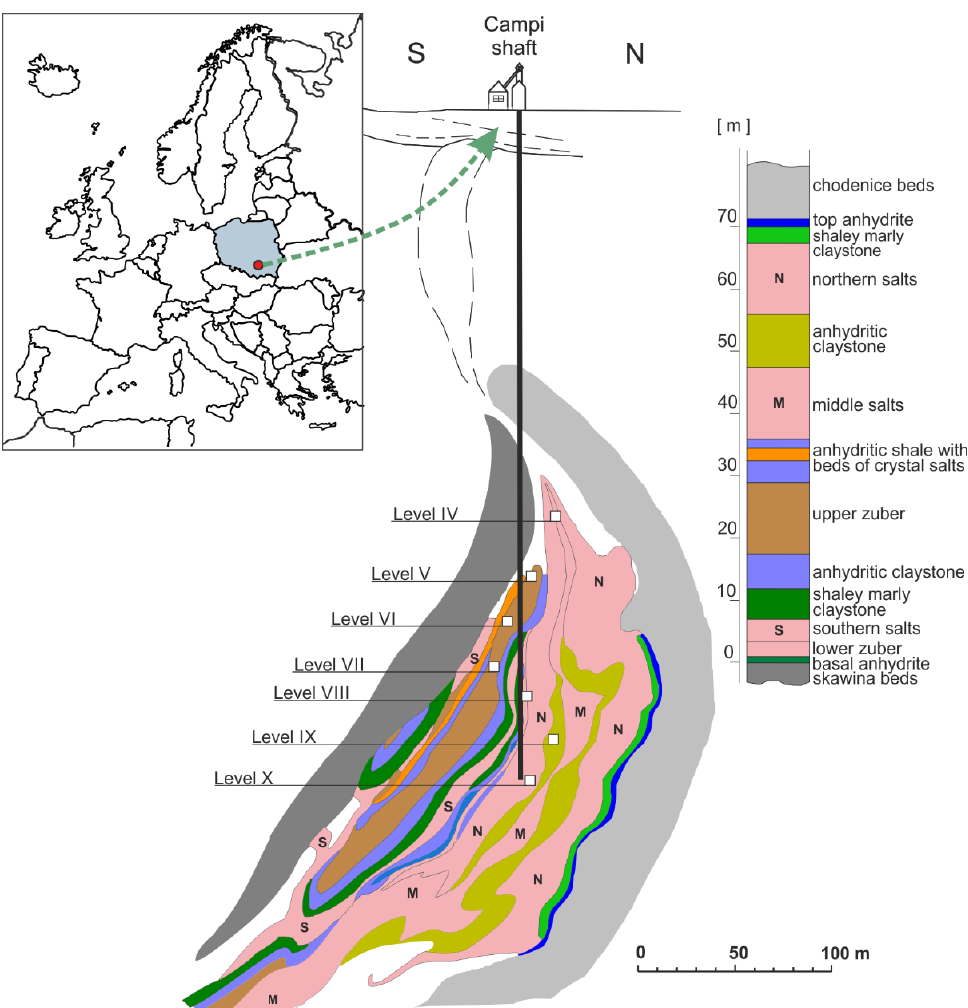
Figure 1. Geology of Bochnia salt deposit: a simplified structure of a cross-section around the Campi shaft and a lithostratigraphic profile of salt succession (according to Poborski [46], modified).